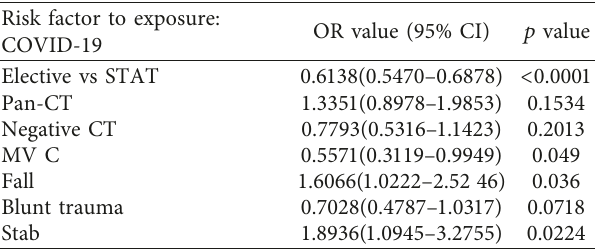
Table 2: The odds ratio with 95% CI of risk factors in first lockdown COVID-19